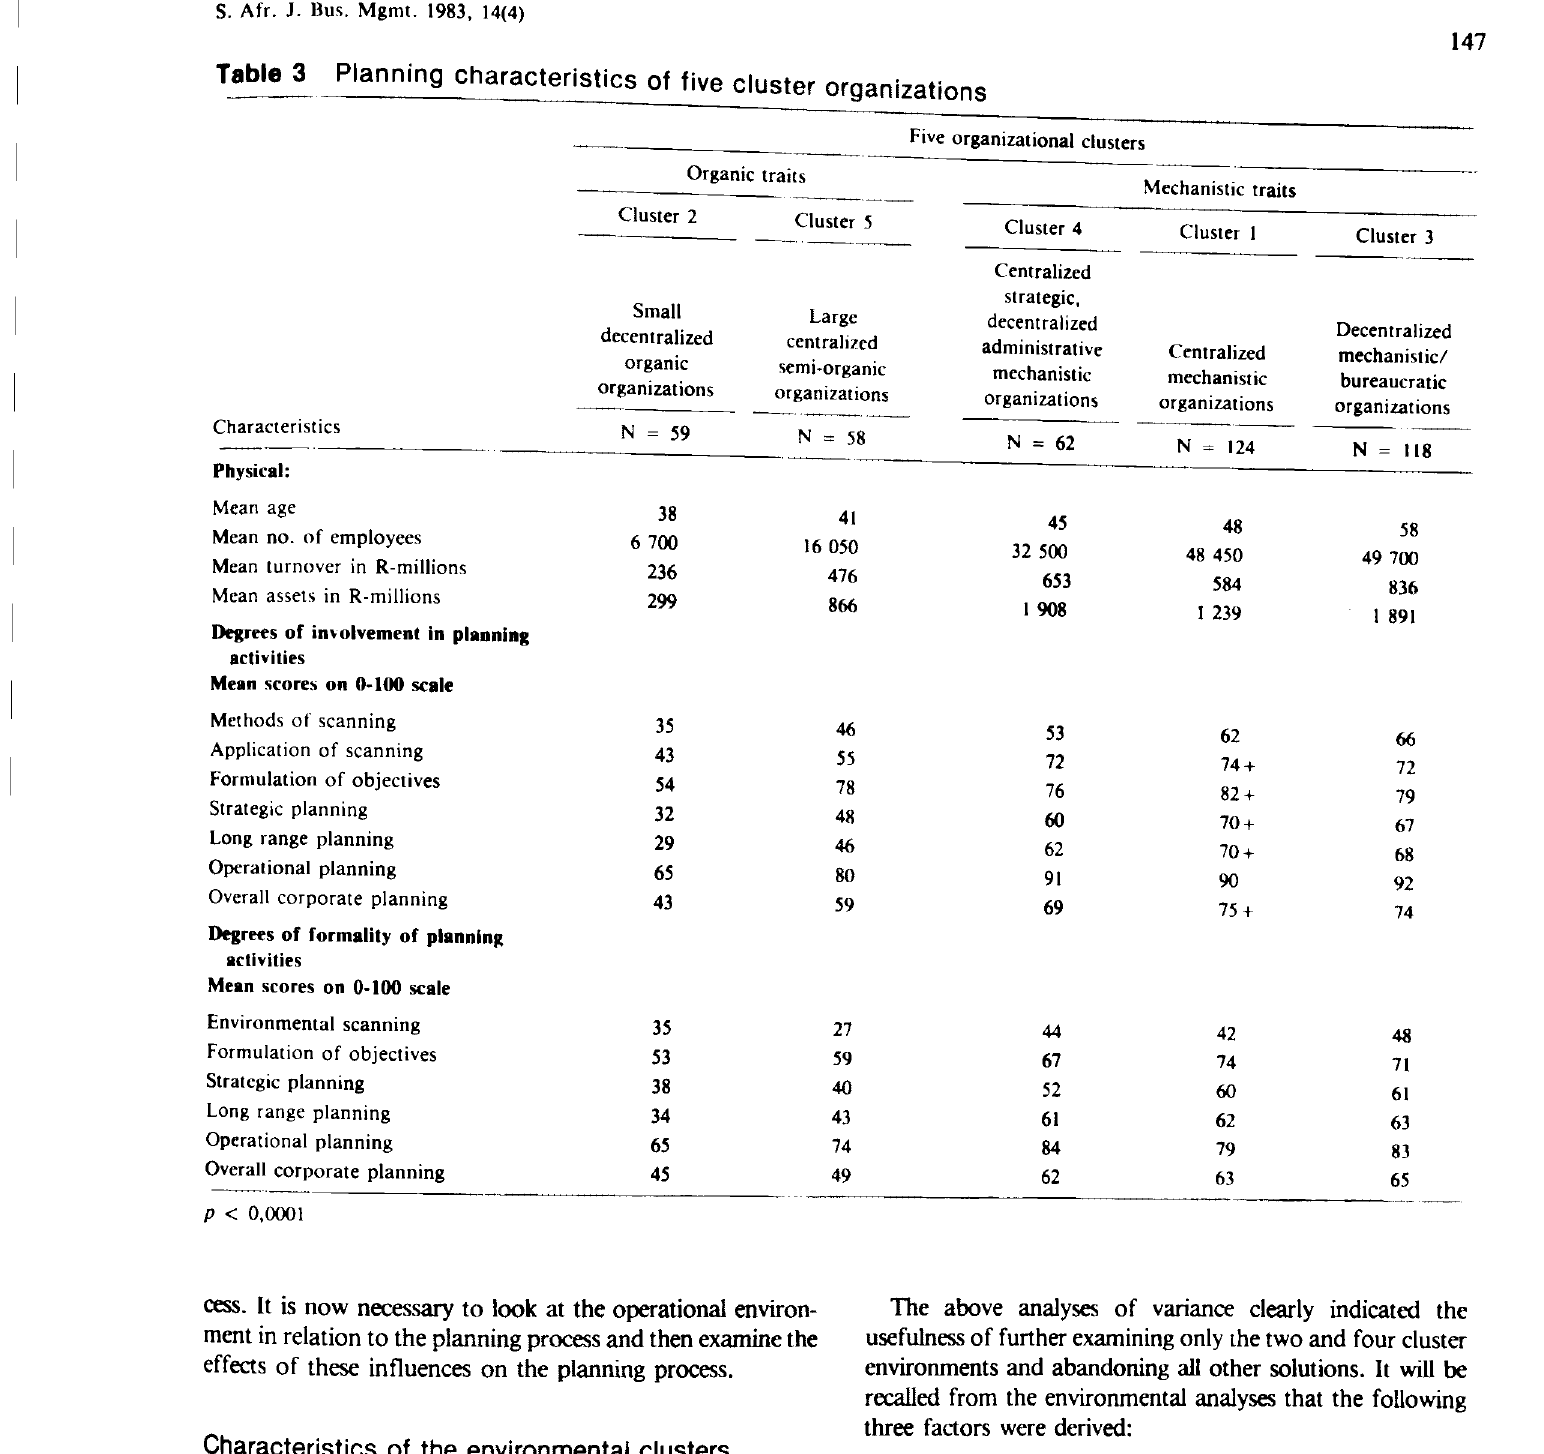
Planning characteristics of five cluster organizations